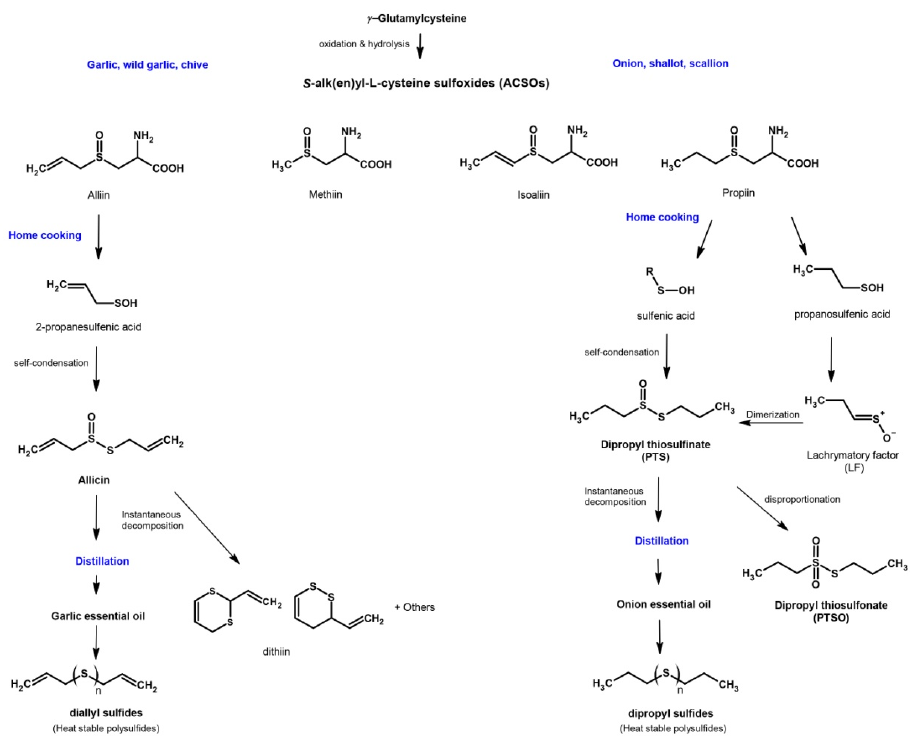
Figure 2. Route of formation of the main organosulfur compounds in garlic and onion.